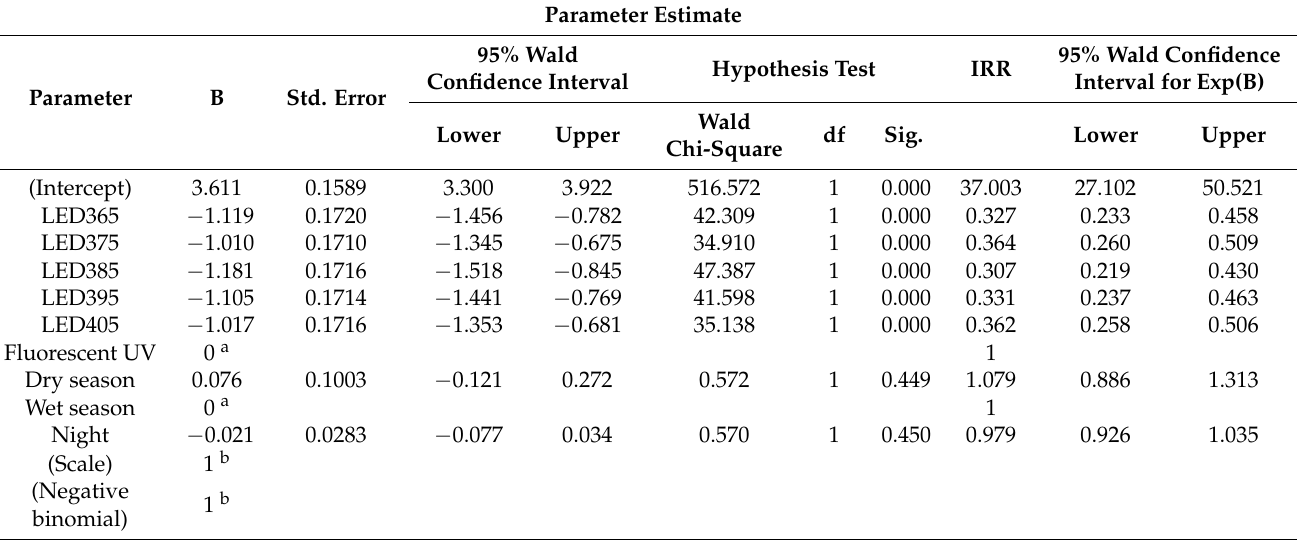
Table 4. Incidence rate ratios of factors influencing efficacy of light traps to capture nocturnally active